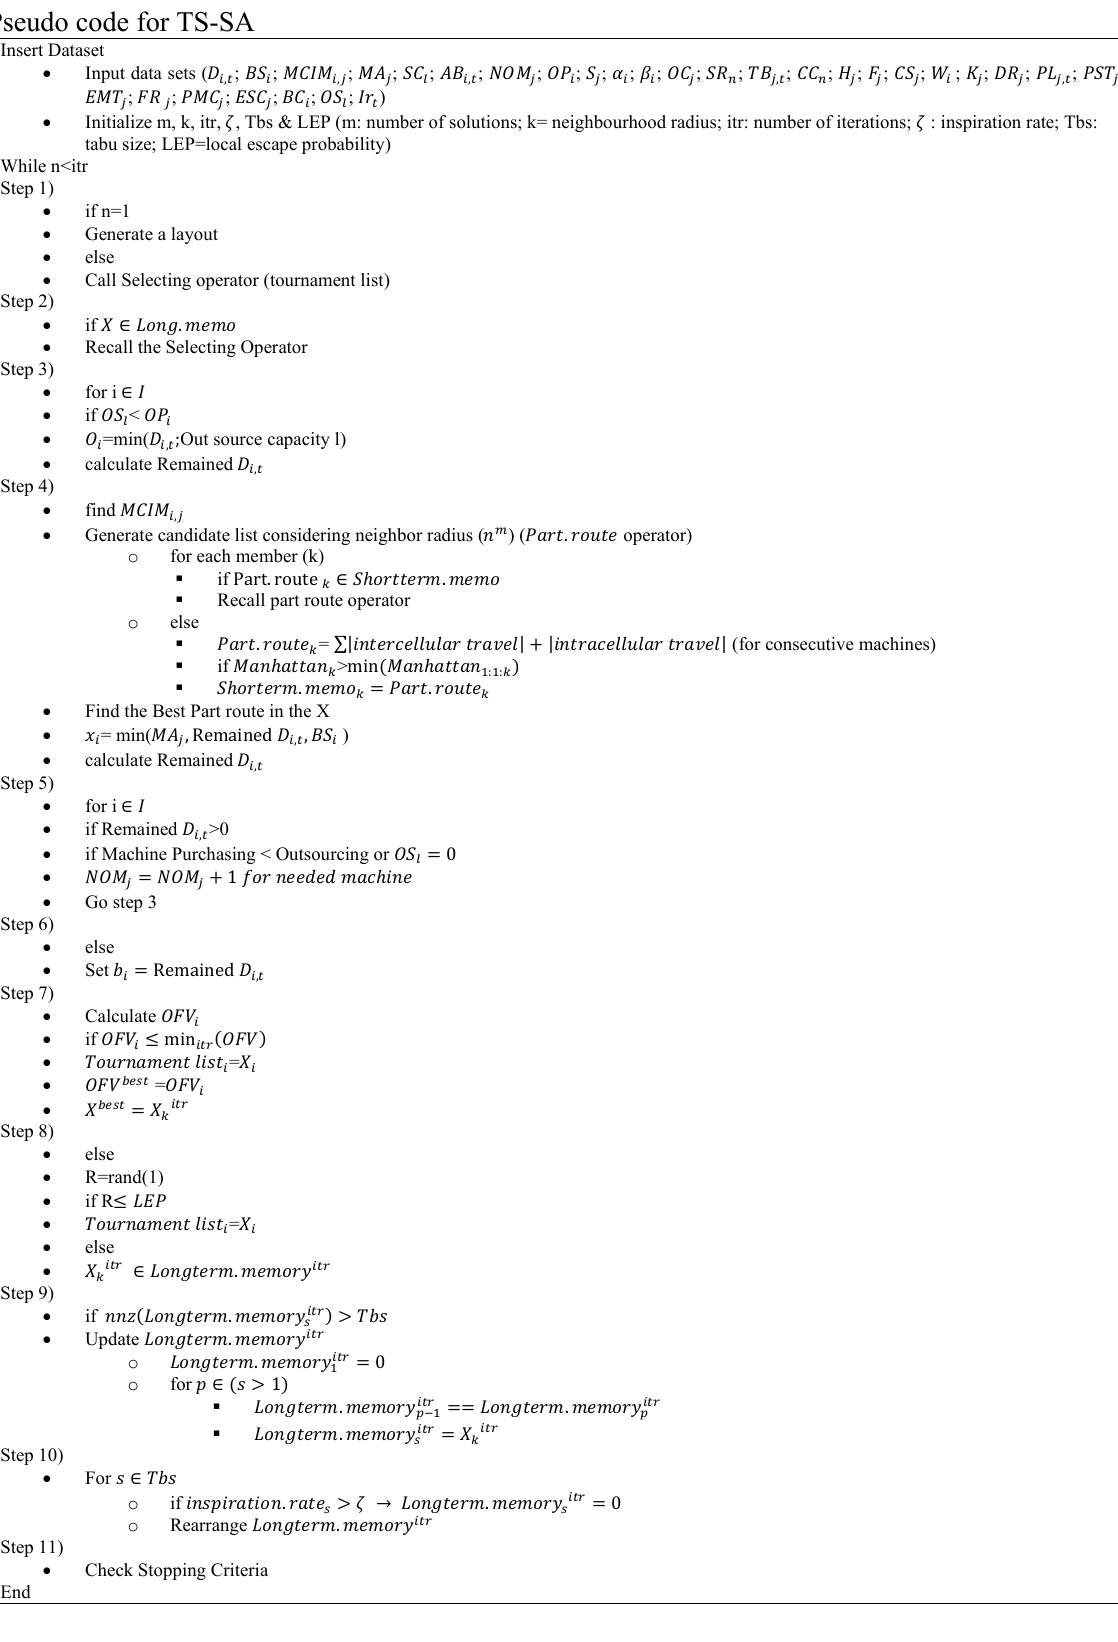
Pseudo code for TS-SA Insert Dataset